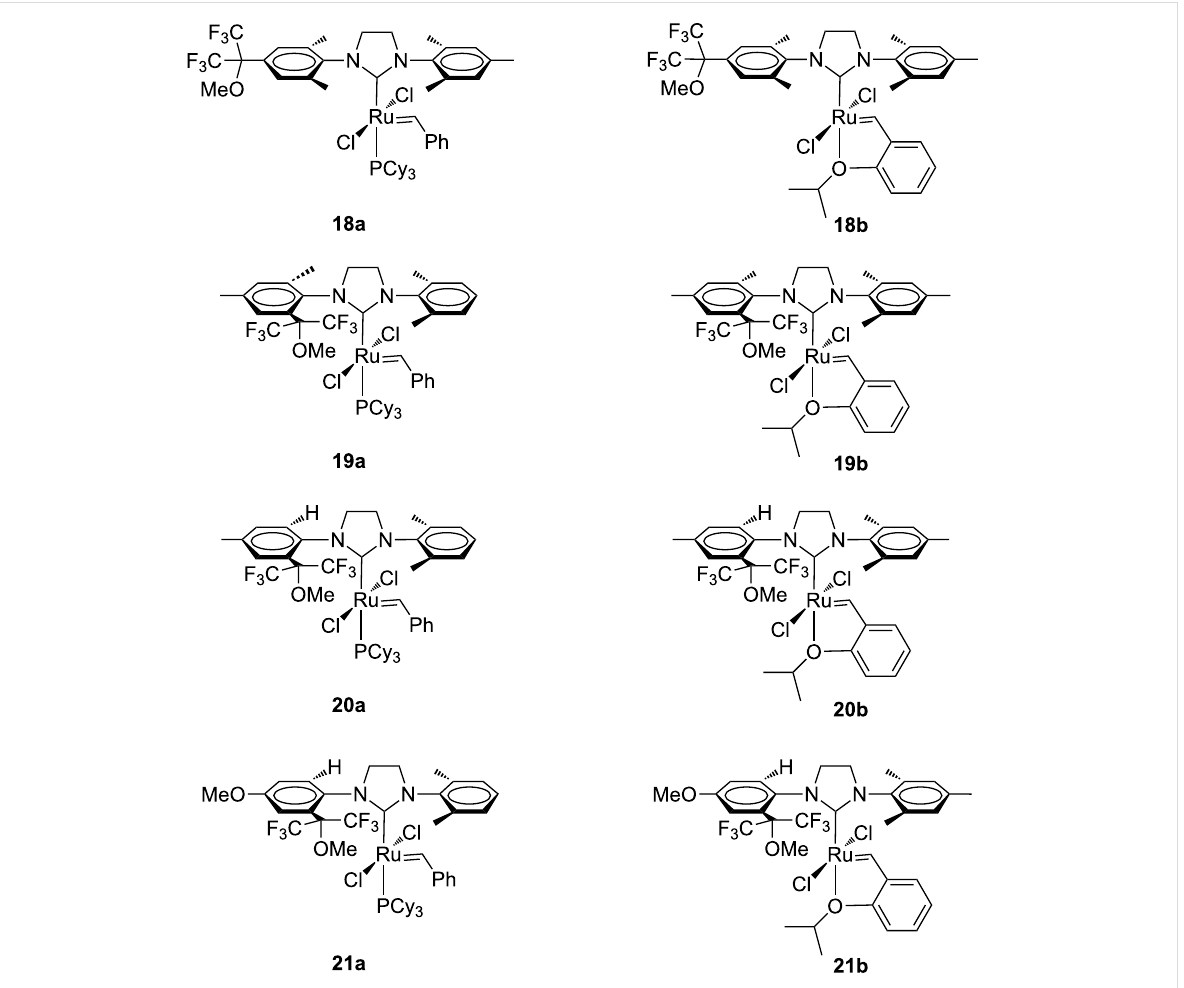
Figure 5: Grubbs ( 18a – 21a ) and Hoveyda-type ( 18b – 21b ) catalysts bearing uNHCs with a hexafluoroisopropylalkoxy [(CF 3 ) 2 (OR)-C] group in one of the N -aryl substituents.